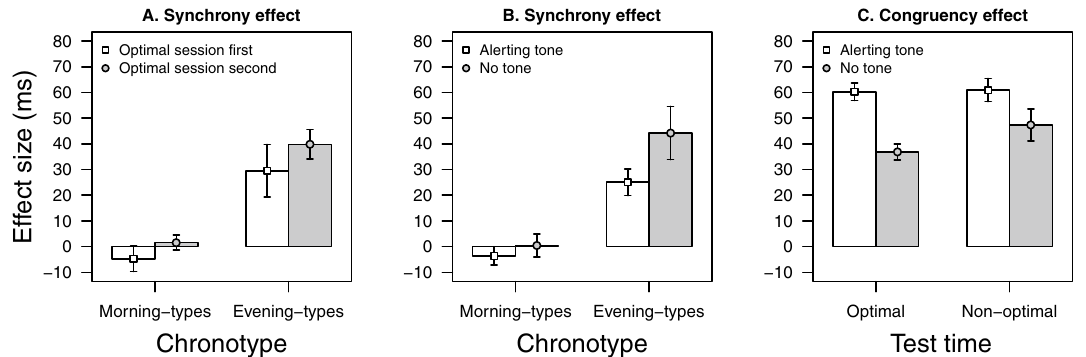
Figure 2. ( A ) Synchrony effect (RT at the non-optimal time minus RT at the optimal time) as a function of chronotype and order. ( B ) Synchrony effect as a function of chronotype and alerting tone. ( C )